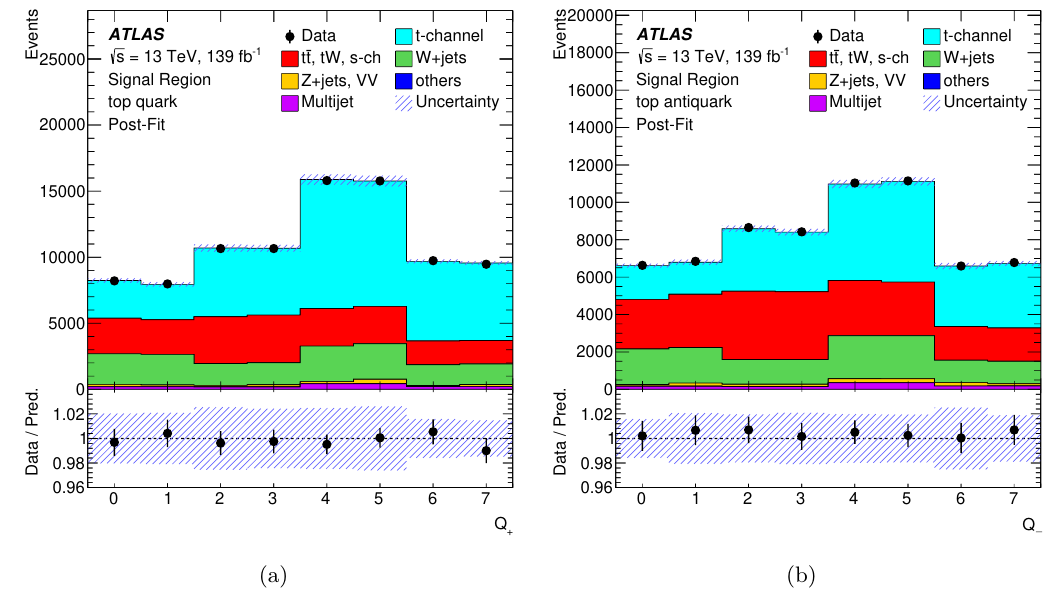
Figure 4 . Observed data and fitted distributions of the octant variable (a) Q + in the top-quark and (b) Q in the top-antiquark signal regions. The Q variable is assigned an integer value zero − through seven according to Q = 4 · Θ(cos θ ) + 2 · Θ(cos θ ) + Θ(cos θ ) where Θ( ξ ) is the ‘z 0 ‘x 0 ‘y 0 Heaviside step function of the variable ξ . The label ‘others’ represents t ¯ tZ , t ¯ tW , tZq , tHq , and tWZ production. The uncertainty bands include both the statistical and systematic uncertainties. The lower panels show the ratio of data to prediction in each